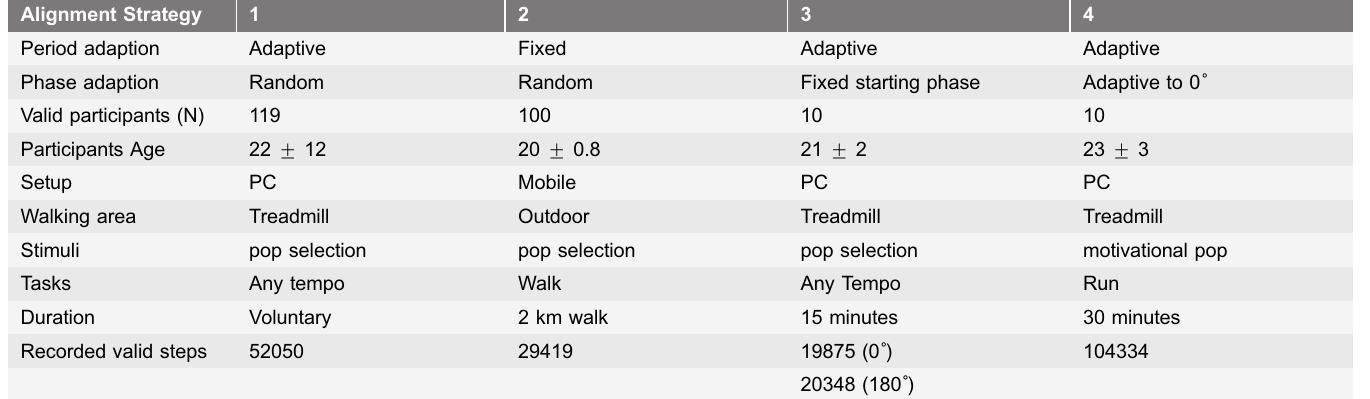
Table 6. Overview of the four alignment strategies and related experiments.